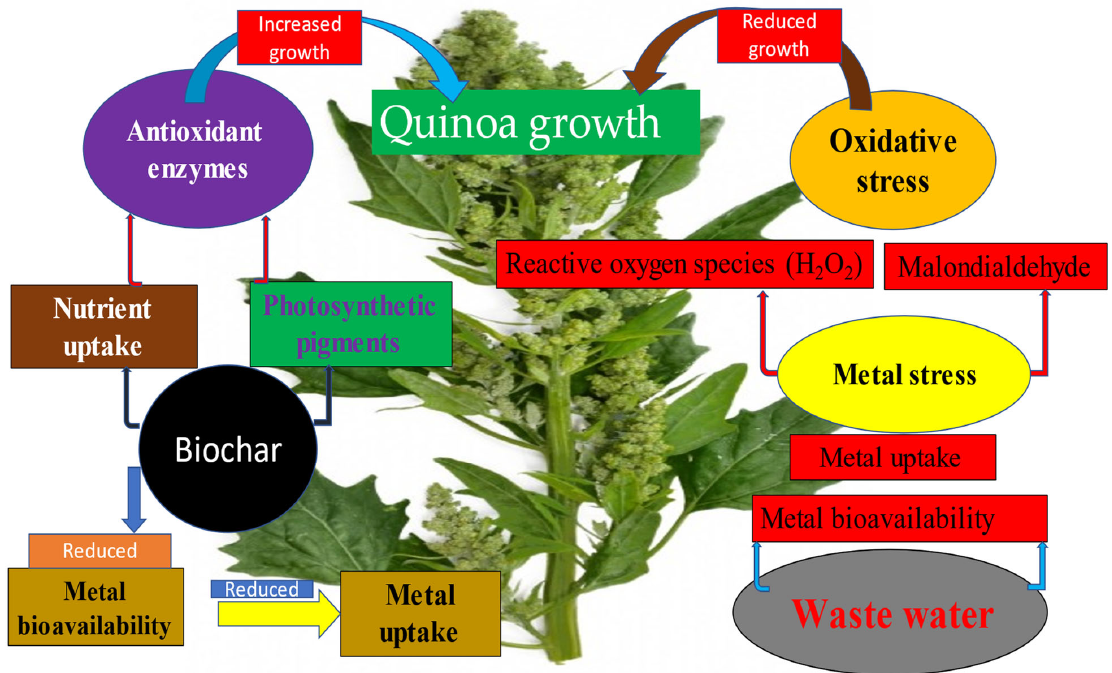
Figure 6. Schematic diagram shows the role of shrimp ‐ waste ‐ derived biochar (SWB) in improving the metal stress resistance of wastewater ‐ irrigated quinoa.